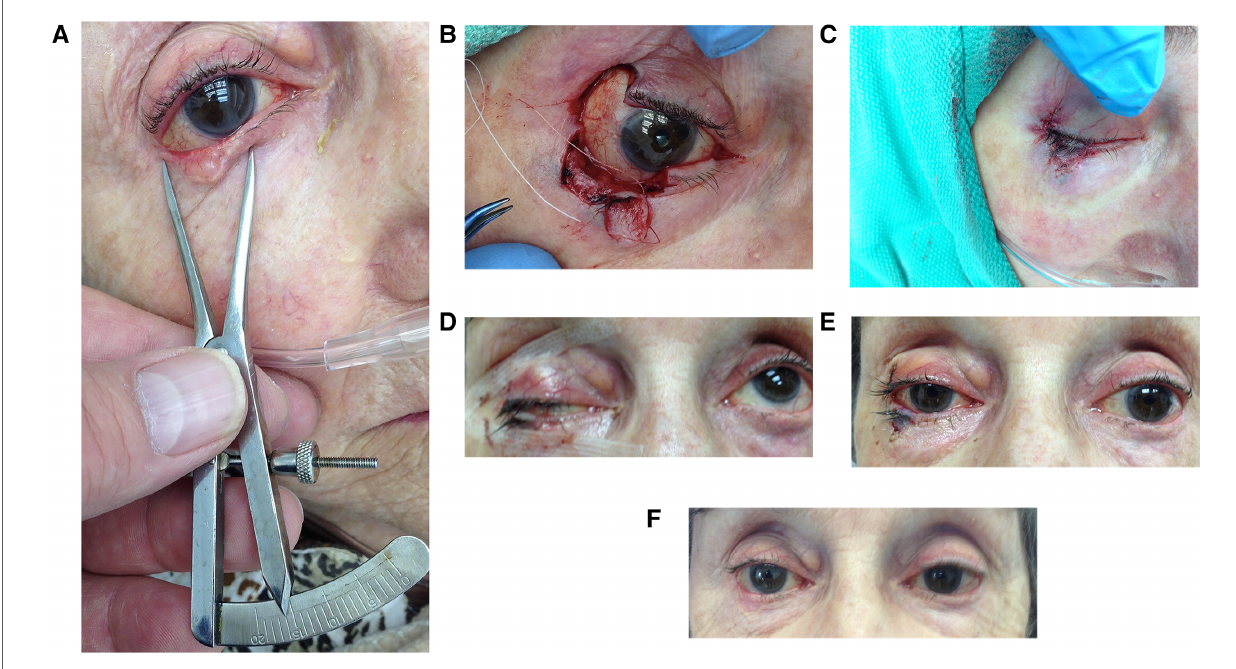
FIGURE 1 A stepwise photo series of the FBA procedure. ( A ) Preliminary measurement of tumor, ( B ) donor lid harvested and tumor resected with 4 mm margins, ( C ) immediate post-procedure repair of graft and donor site, ( D ) 24 h post-procedure with marked ptosis, ( E ) 6 days after surgery, ( F ) 3 months post- procedure with resolved